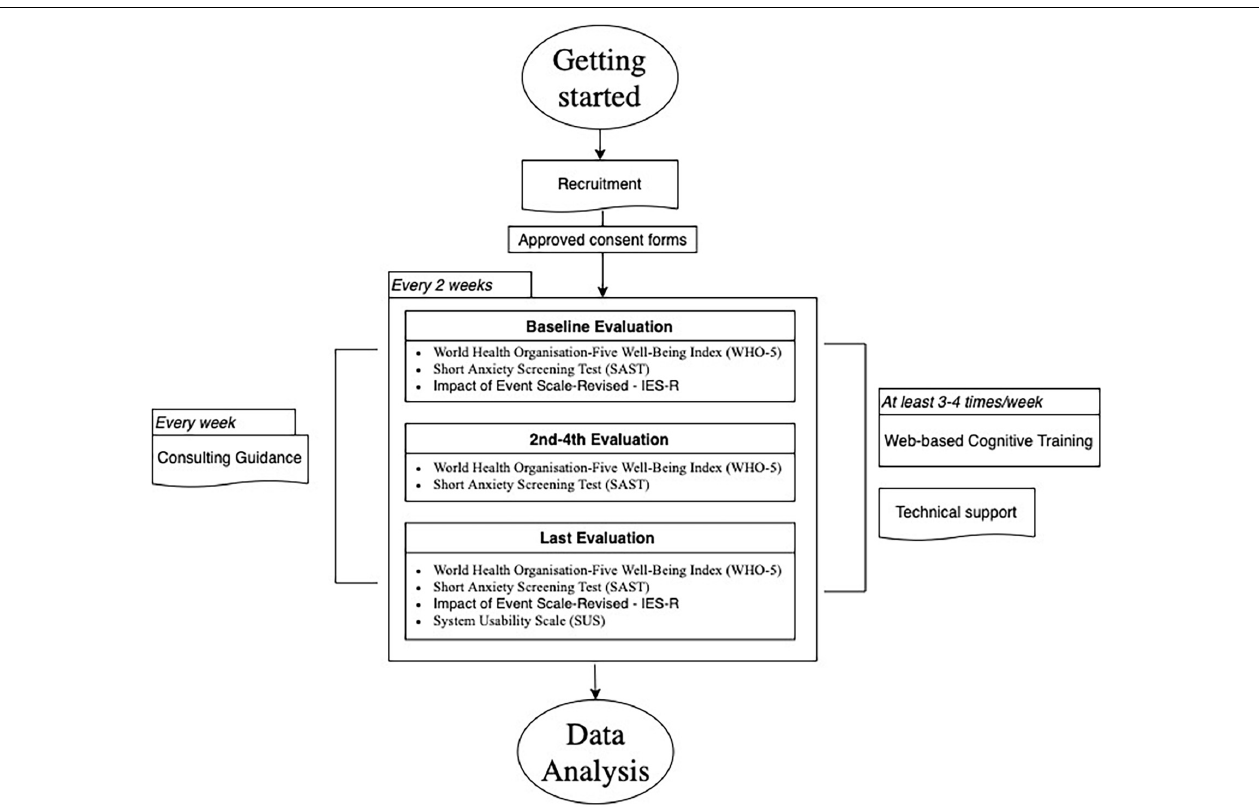
FIGURE 2 | Visualization of the process followed with regard to the